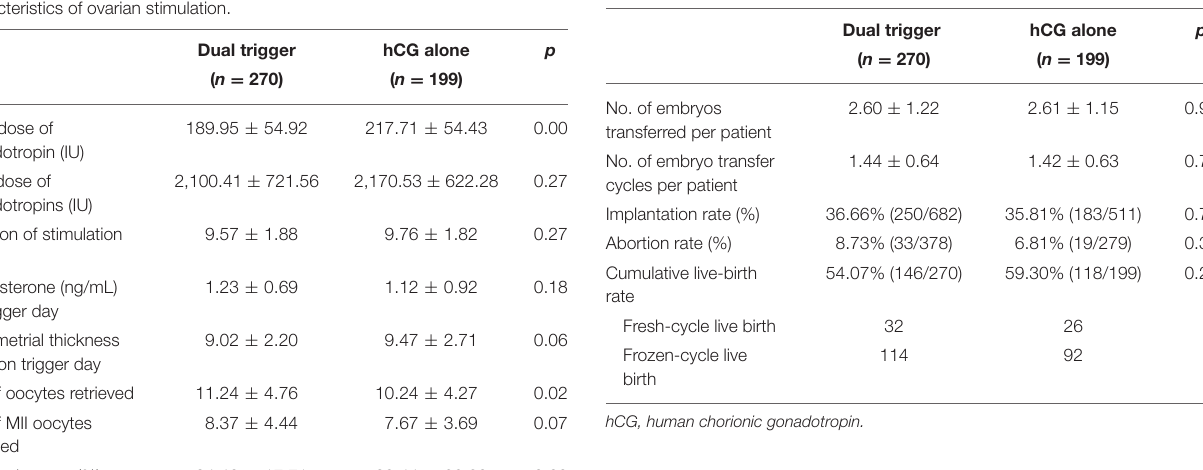
TABLE 4 | Cumulative reproductive outcomes in the study